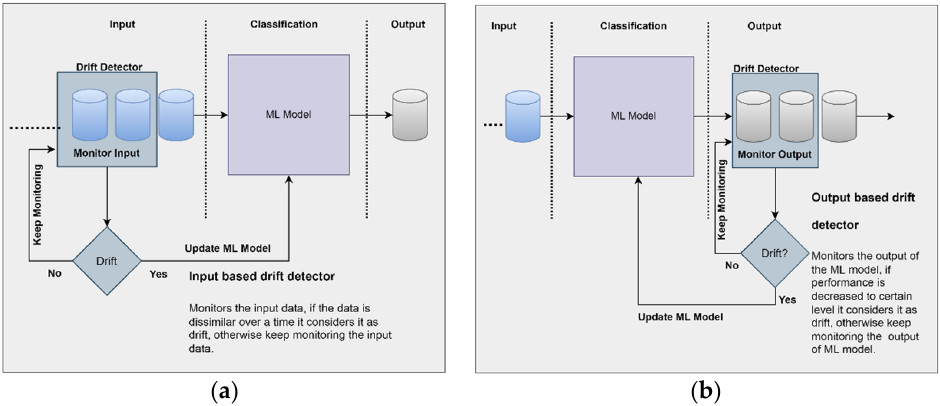
Figure 2. ( a ) Input-based drift detection; ( b ) output-based drift detection.